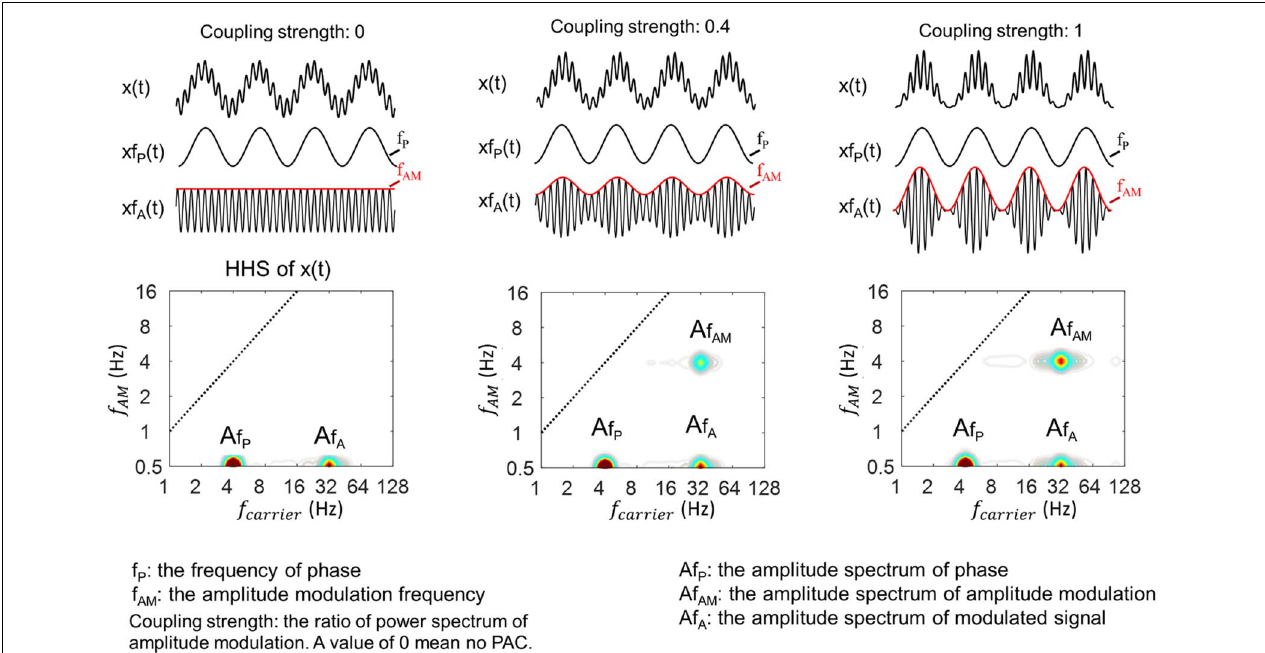
FIGURE 4 | Illustration of HHSA for synthesized data with different coupling strengths, which is the ratio of the modulation depth of xfA(t) in which x(t) = xf P (t)* xf A (t). A value of 0 indicates no modulation depth and 1 for full modulation. (Top) 3 levels differing in coupling strength (top trace) along with their corresponding HHS (bottom panels). The modulated signals with fast oscillations are plotted underneath with the amplitude envelope increasing from the top. The synthesized signals all consisted of summation of a 4 Hz sinusoidal signal and an amplitude-modulated signal with 32 Hz modulated by 4 Hz.